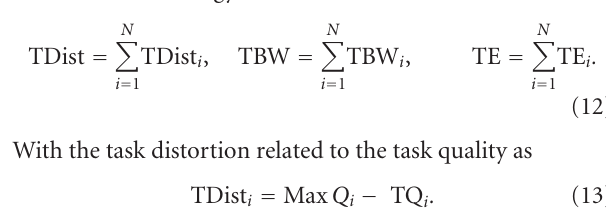
Figure 1: Example of